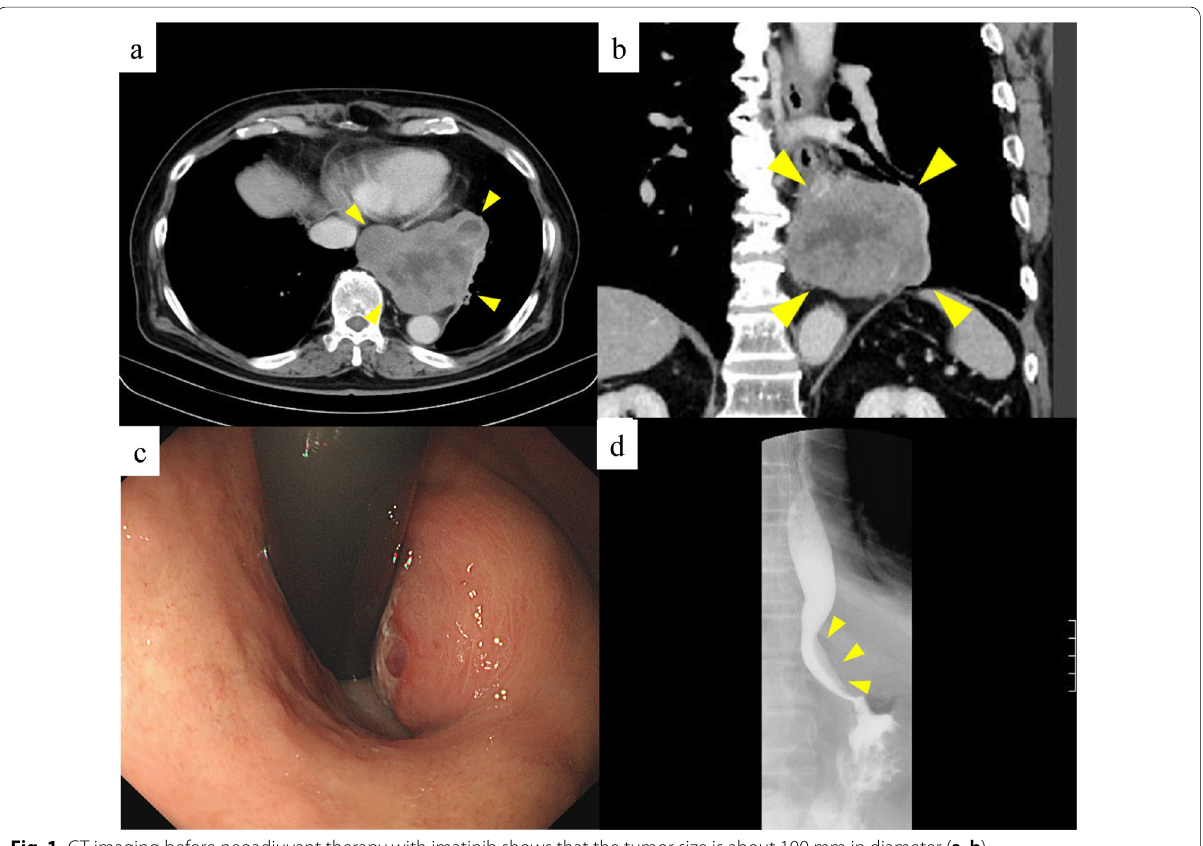
Fig. 1 CT imaging before neoadjuvant therapy with imatinib shows that the tumor size is about 100 mm in diameter ( a , b ). Esophagogastroduodenoscopy reveals a submucosal tumor with a narrowed lumen and ulceration in the lower esophagus ( c ). Upper gastrointestinal series reveals compression towards the left side of the esophagus without mucosal changes ( d